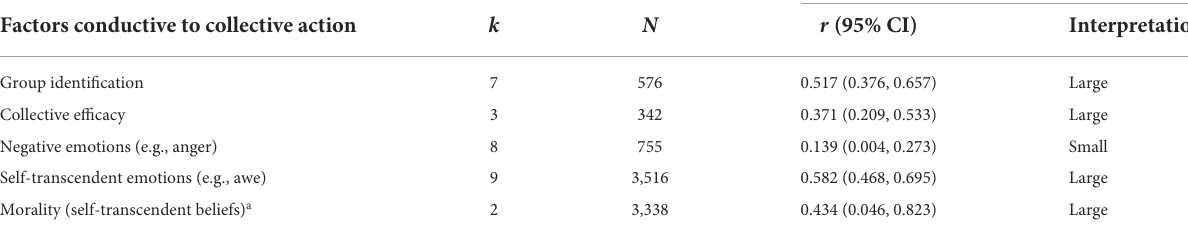
TABLE 5 Pooled correlations between collective effervescence on factors conductive to collective action in